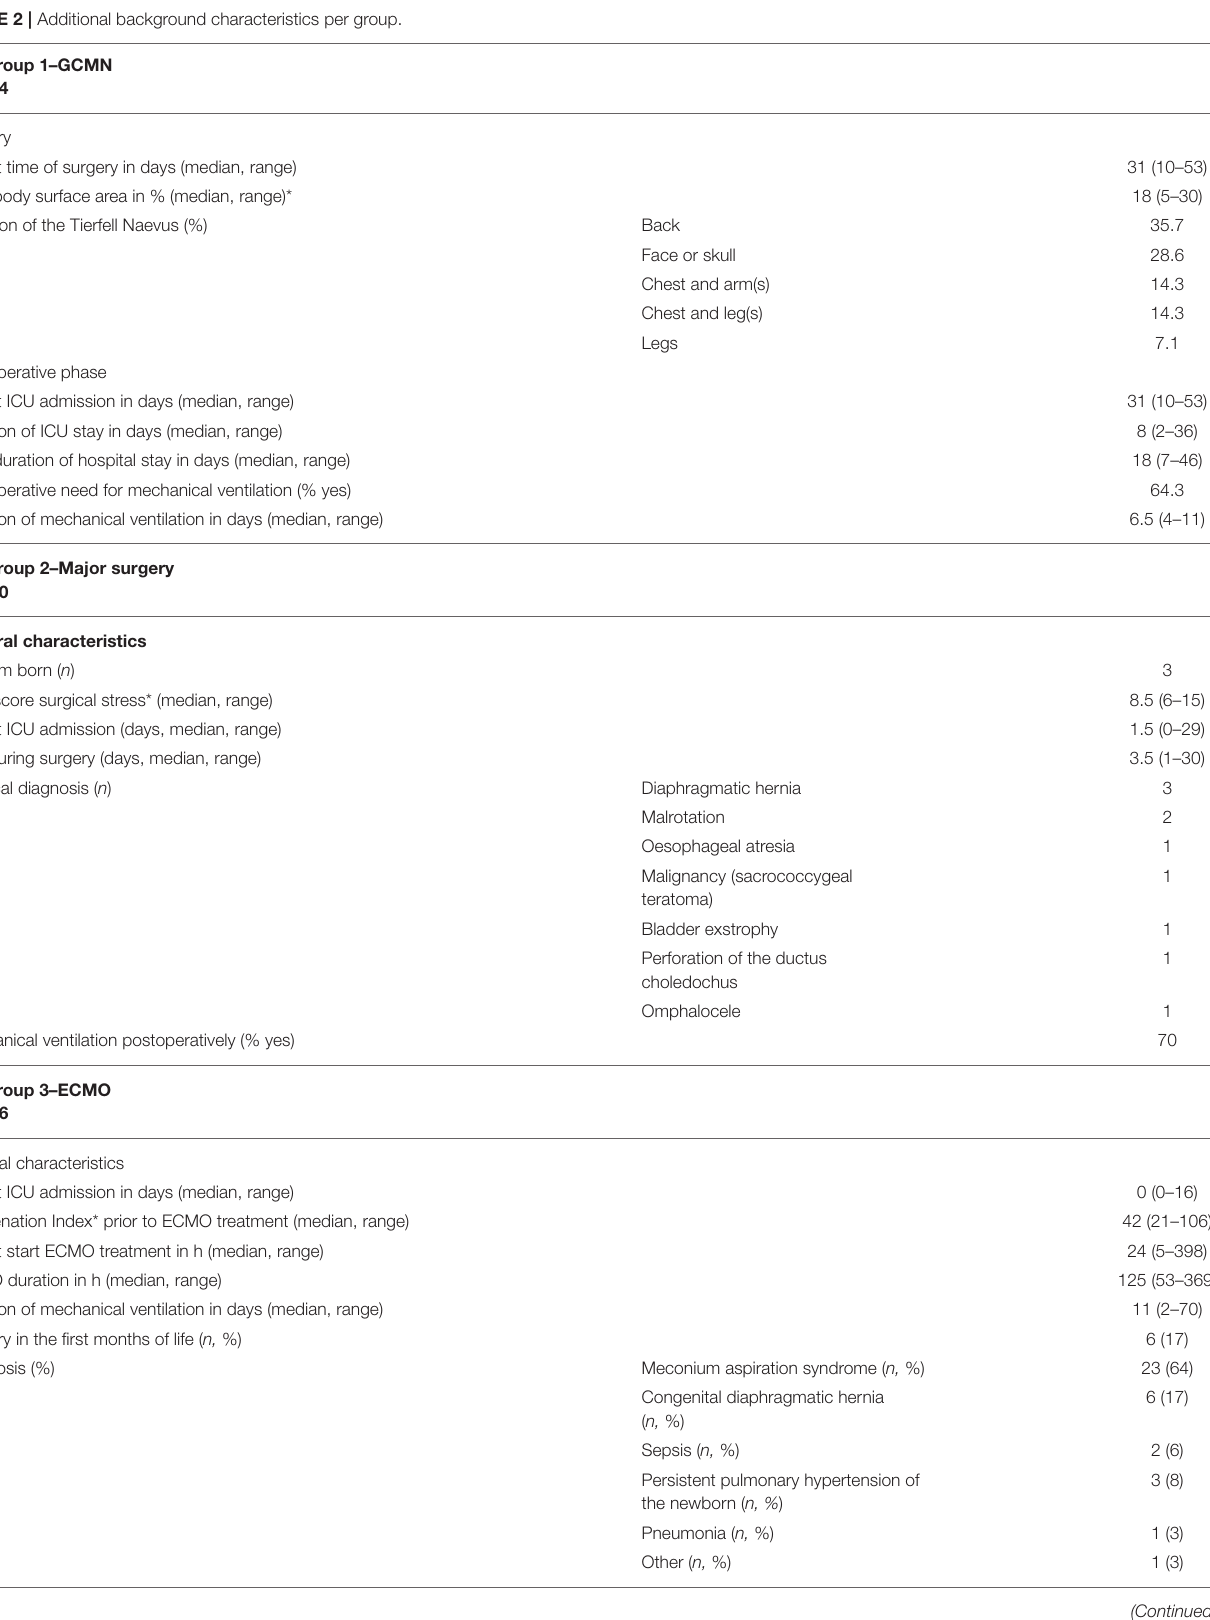
TABLE 2 | Additional background characteristics per